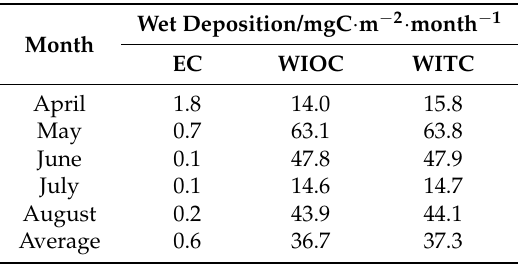
Table 2. Monthly wet deposition fluxes of EC, WIOC and WITC at